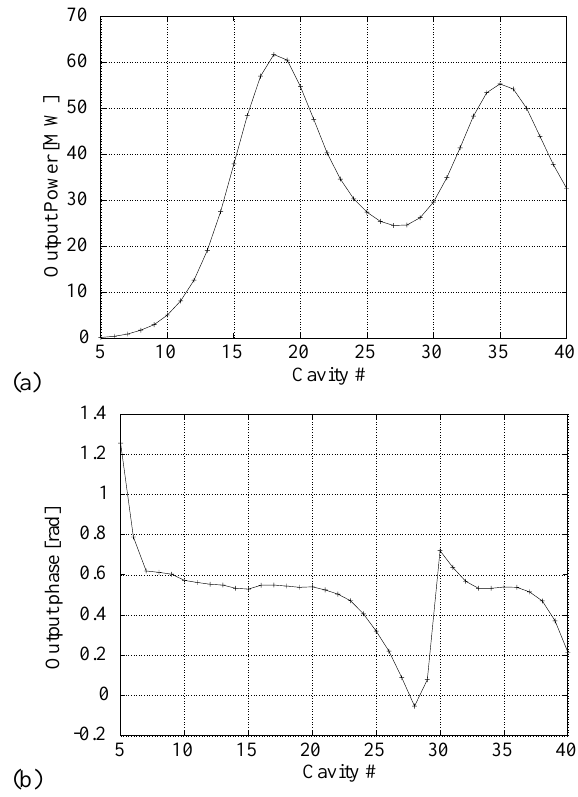
FIG. 14. Steady-state output power (a) and phase (b) in the main TBA section.